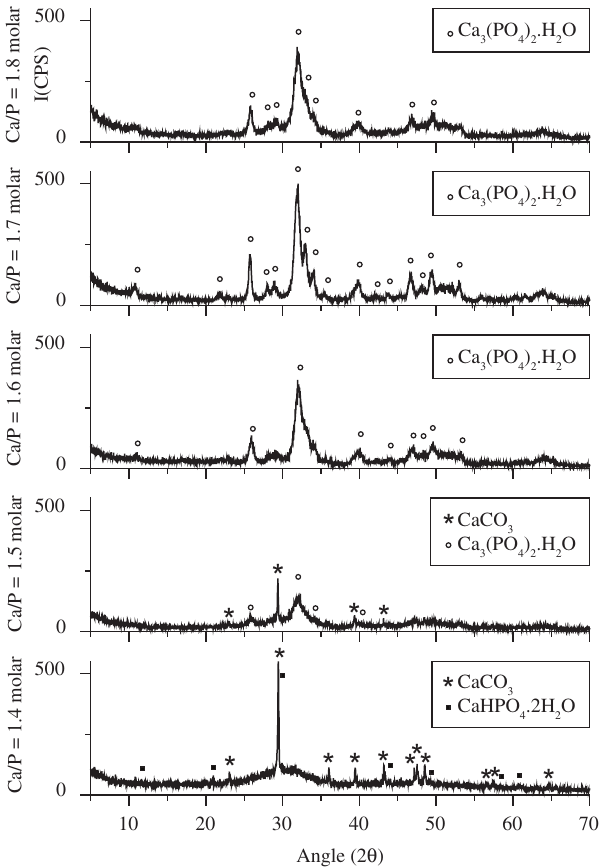
Figure 4. Spectra of X ray diffractometry on the biocement powders resulting from the heat treatment at 1300 °C for 2 hours for the different compositions (peaks per second as a function of 2 θ ).